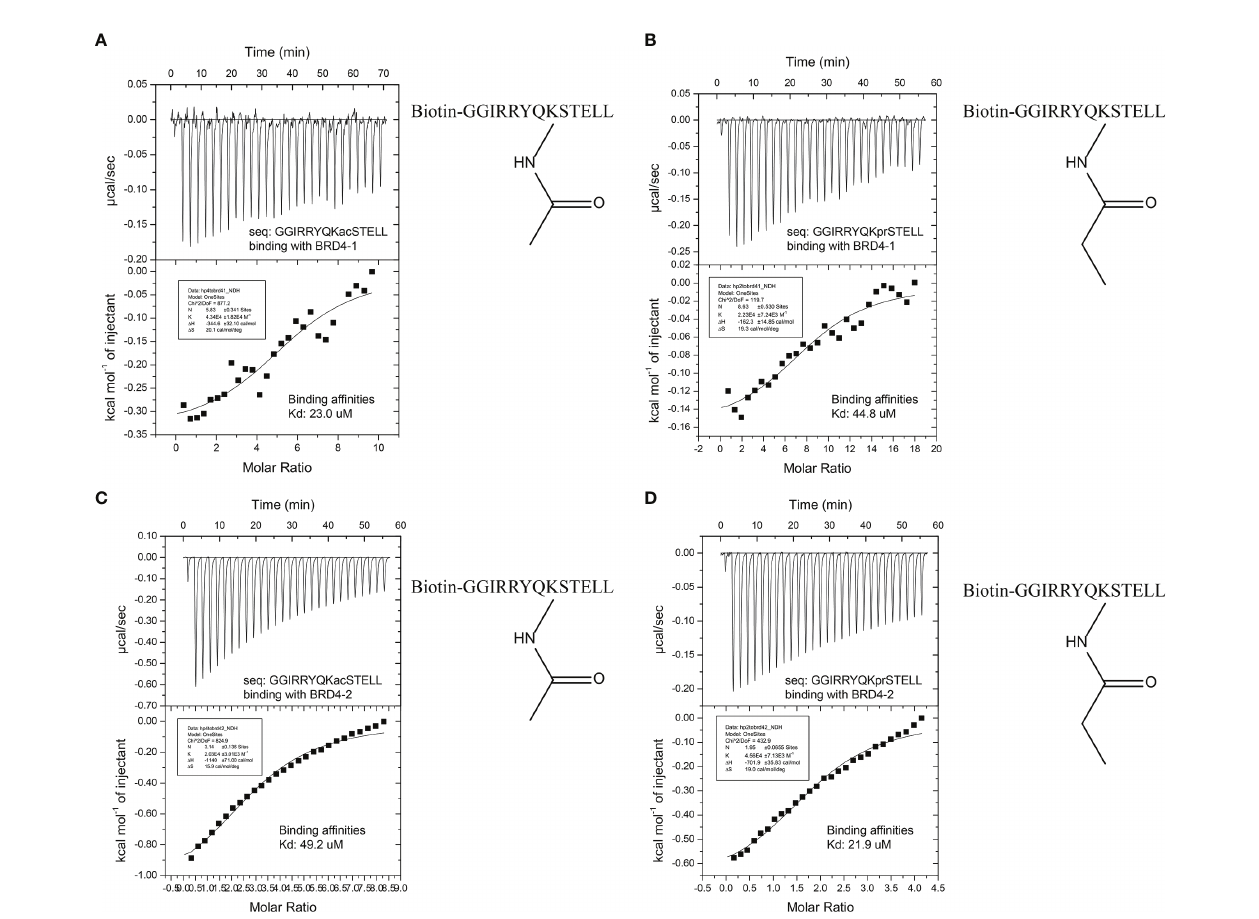
FIGURE 4 | (A) Isothermal titration calorimetry (ITC) data of the acetylated histone peptide H3K56 ( Ac ) binding to BRD4 (1). (B) ITC data of the propionylated histone peptide H3K56 ( Pr ) binding to BRD4 (1). (C) ITC data of the acetylated histone peptide H3k56 ( Ac ) binding to BRD4 (2). (D) ITC data of the propionylated histone peptide H3k56 ( Pr ) binding to BRD4